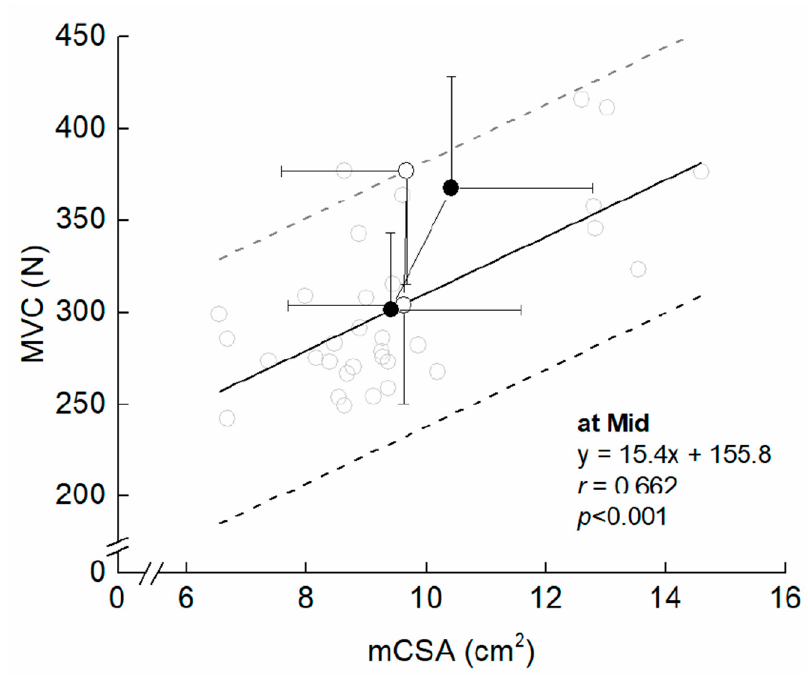
Figure 5. Training-induced changes in maximal voluntary isometric contraction (MVC) and muscle cross-sectional area (mCSA) in the elbow flexors. The grey opened circle denotes an individual’s plot at Mid. The black filled circles indicate means and SDs in COMB, from Mid to Post. The open circles represent means and SDs in ST, from Mid to Post. The black line indicates regression line derived from the corresponding relationship. The dashed line indicates ± 2SDs derived from the single regression line.